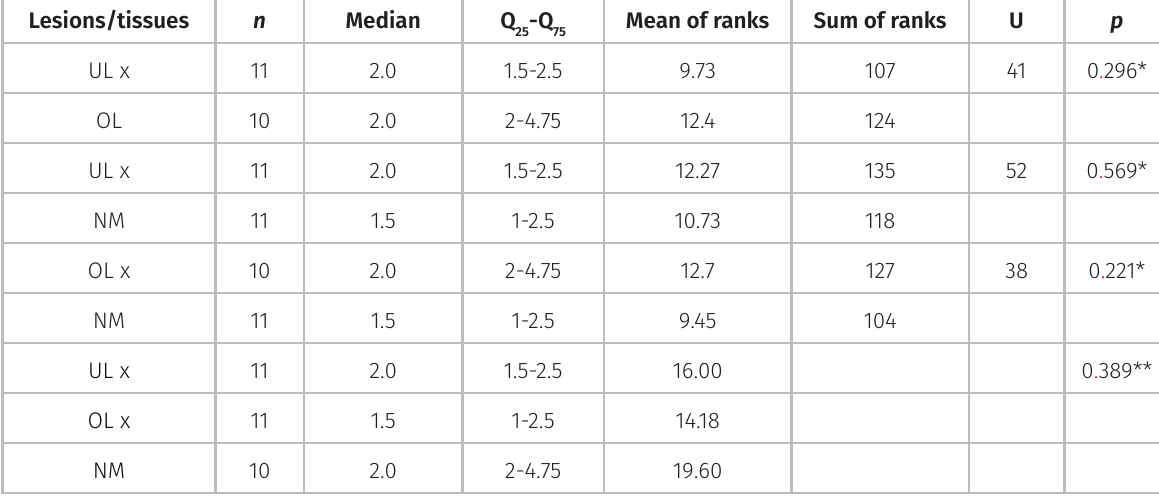
Table II. Distribution of mast cells between the different lesions. Lesions/tissues